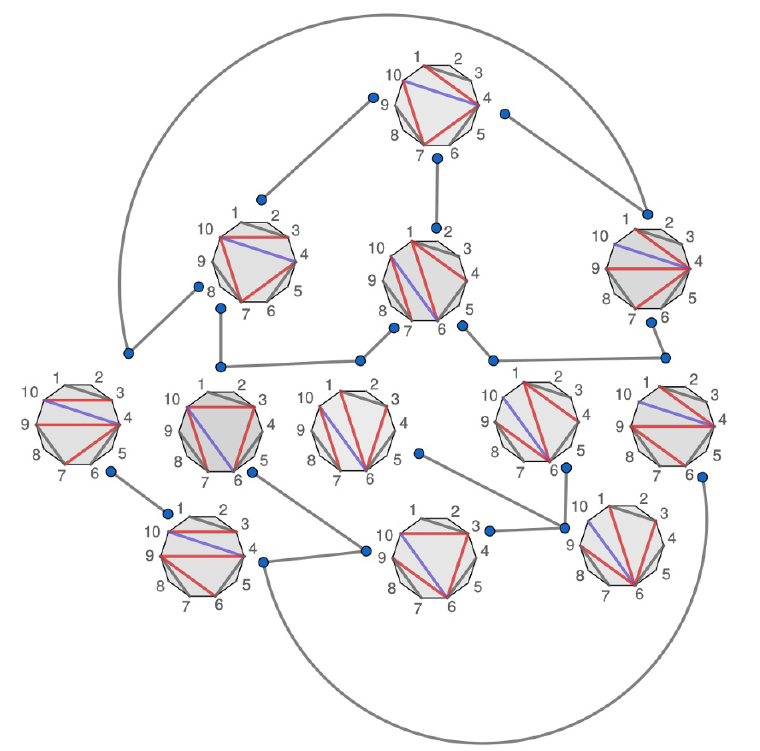
Figure 19 . In the Lucas case the corresponding polytope has 12 vertices, 18 edges and 8 faces. 3. Lucas type: in this the corresponding Stokes Polytope has Lucas number L